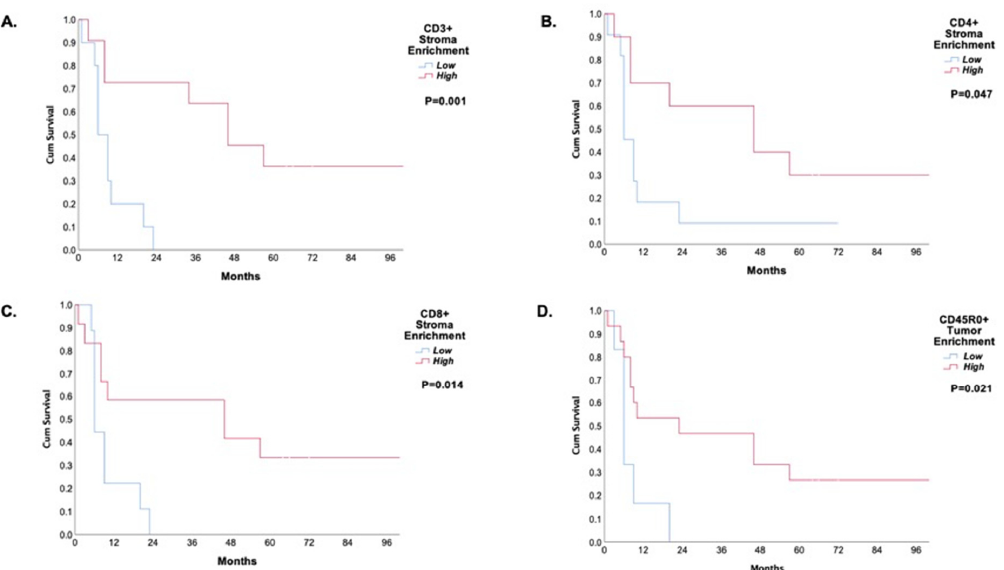
Figure 5. Kaplan–Meier curves of five-year disease-free survival of the neoadjuvant treated patients based on the tumor-infiltrating immune lymphocyte subpopulations. ( A ) CD3+ TIL stroma; ( B ) CD4 + TIL stroma; ( C ) CD8+ TIL stroma; ( D ) CD45RO+ TIL tumor.